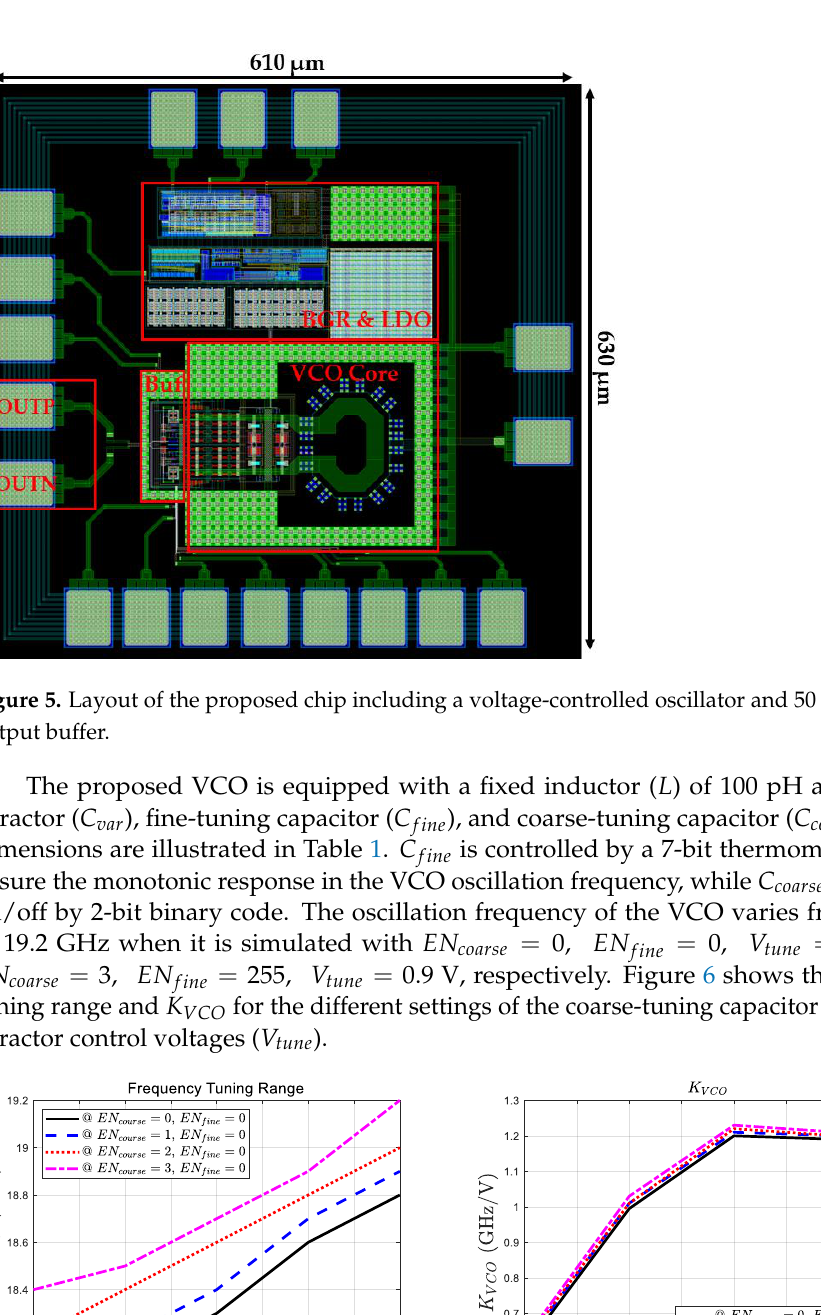
Figure 7. Simulated phase noise (PN) at the lowest ( left ) and highest ( right ) code settings.